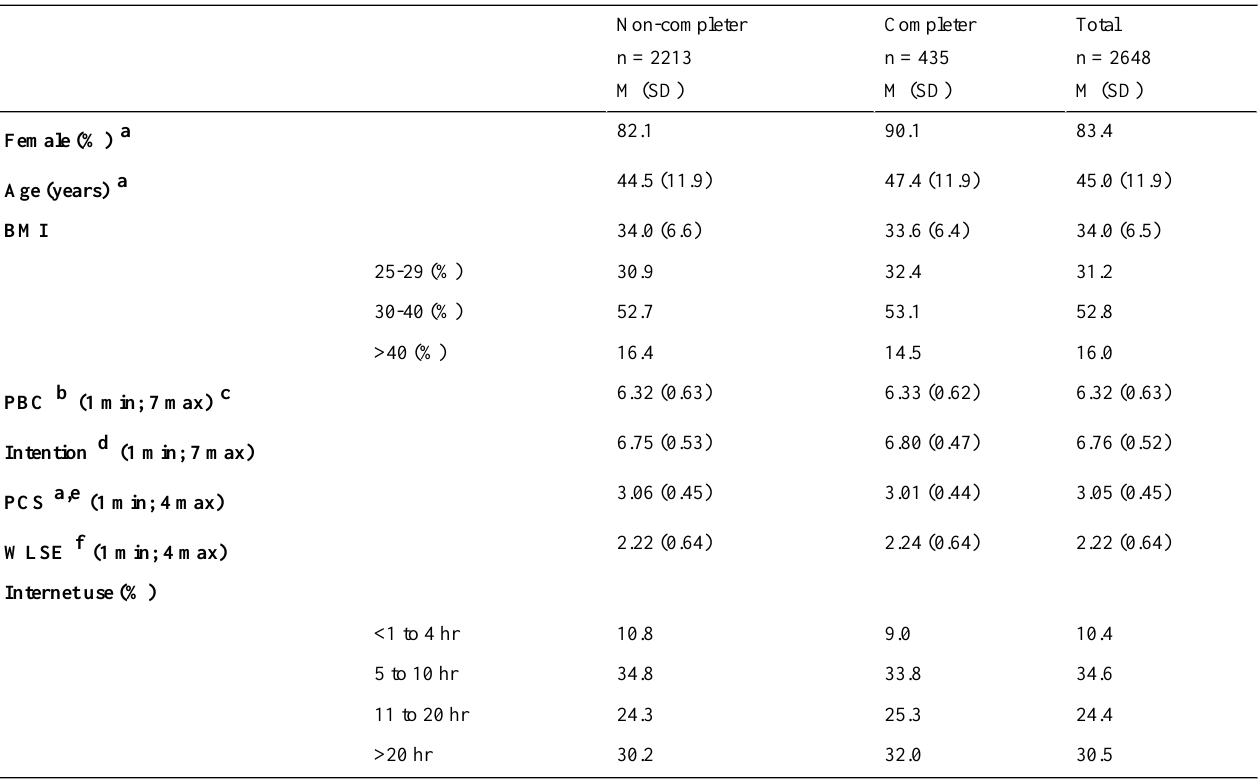
Table 2. Summary statistics of initial questionnaire measures for